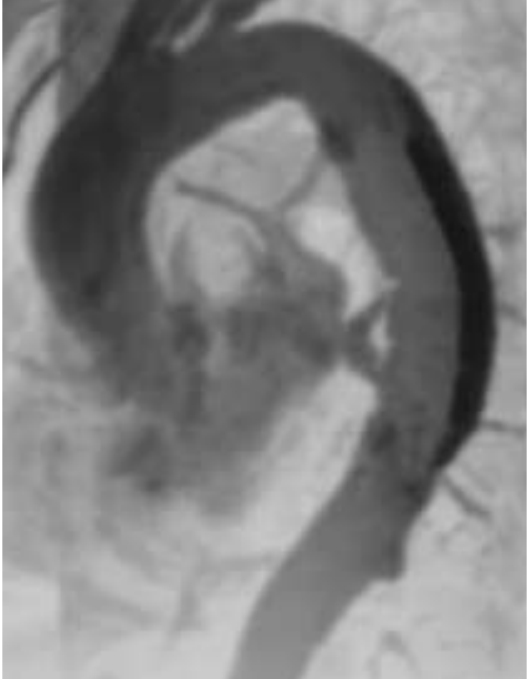
MRI of the excluded